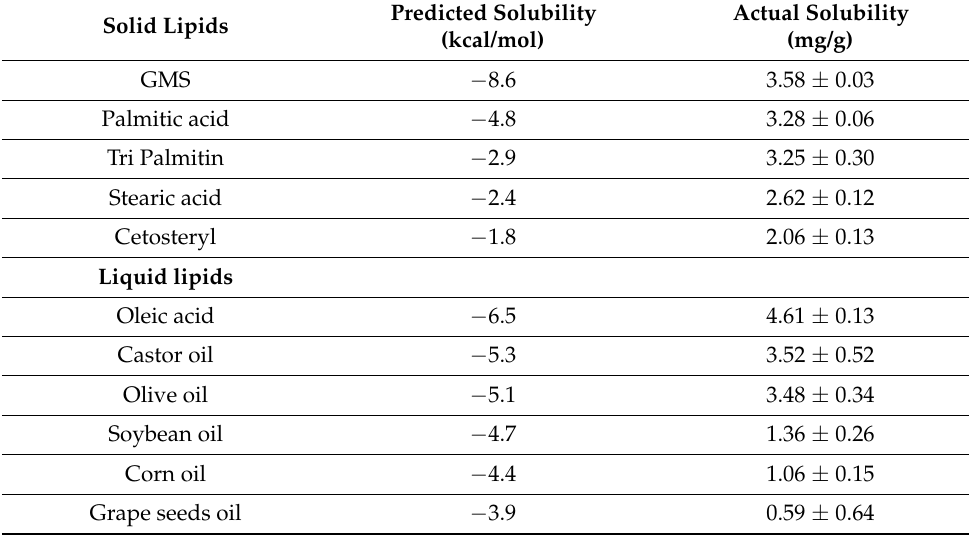
Table 2. Predicted versus actual results of curcumin solubility in different lipids.